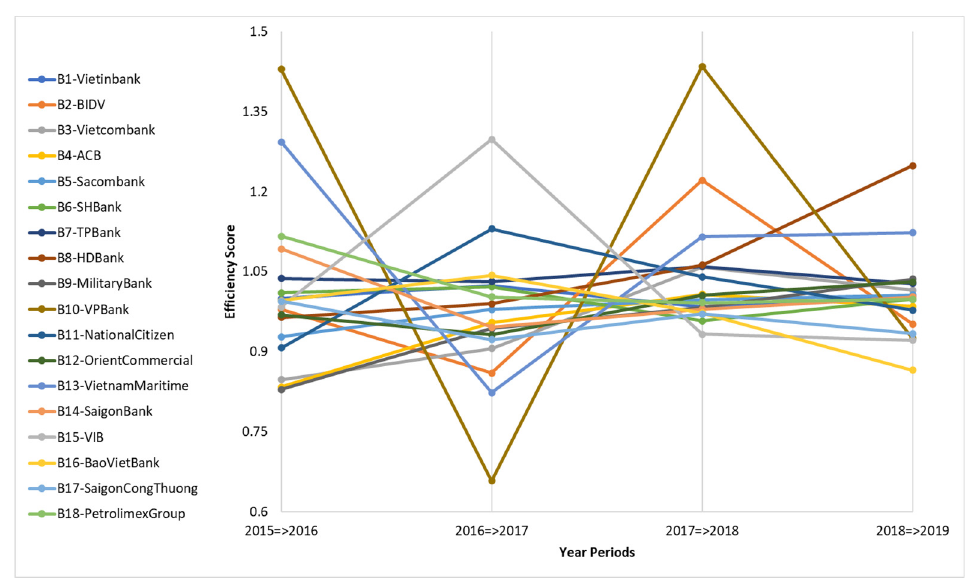
Figure 2. The efficiency change indexes of the DMUs. Half of the banks achieved technical efficiency in the final period (2018–2019), which